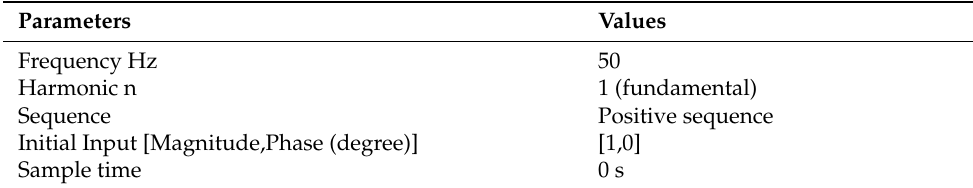
Table 3. Parameters setting for sequence analyzer block.